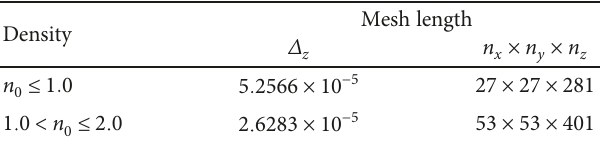
Table 3: Meshing parameters used in the